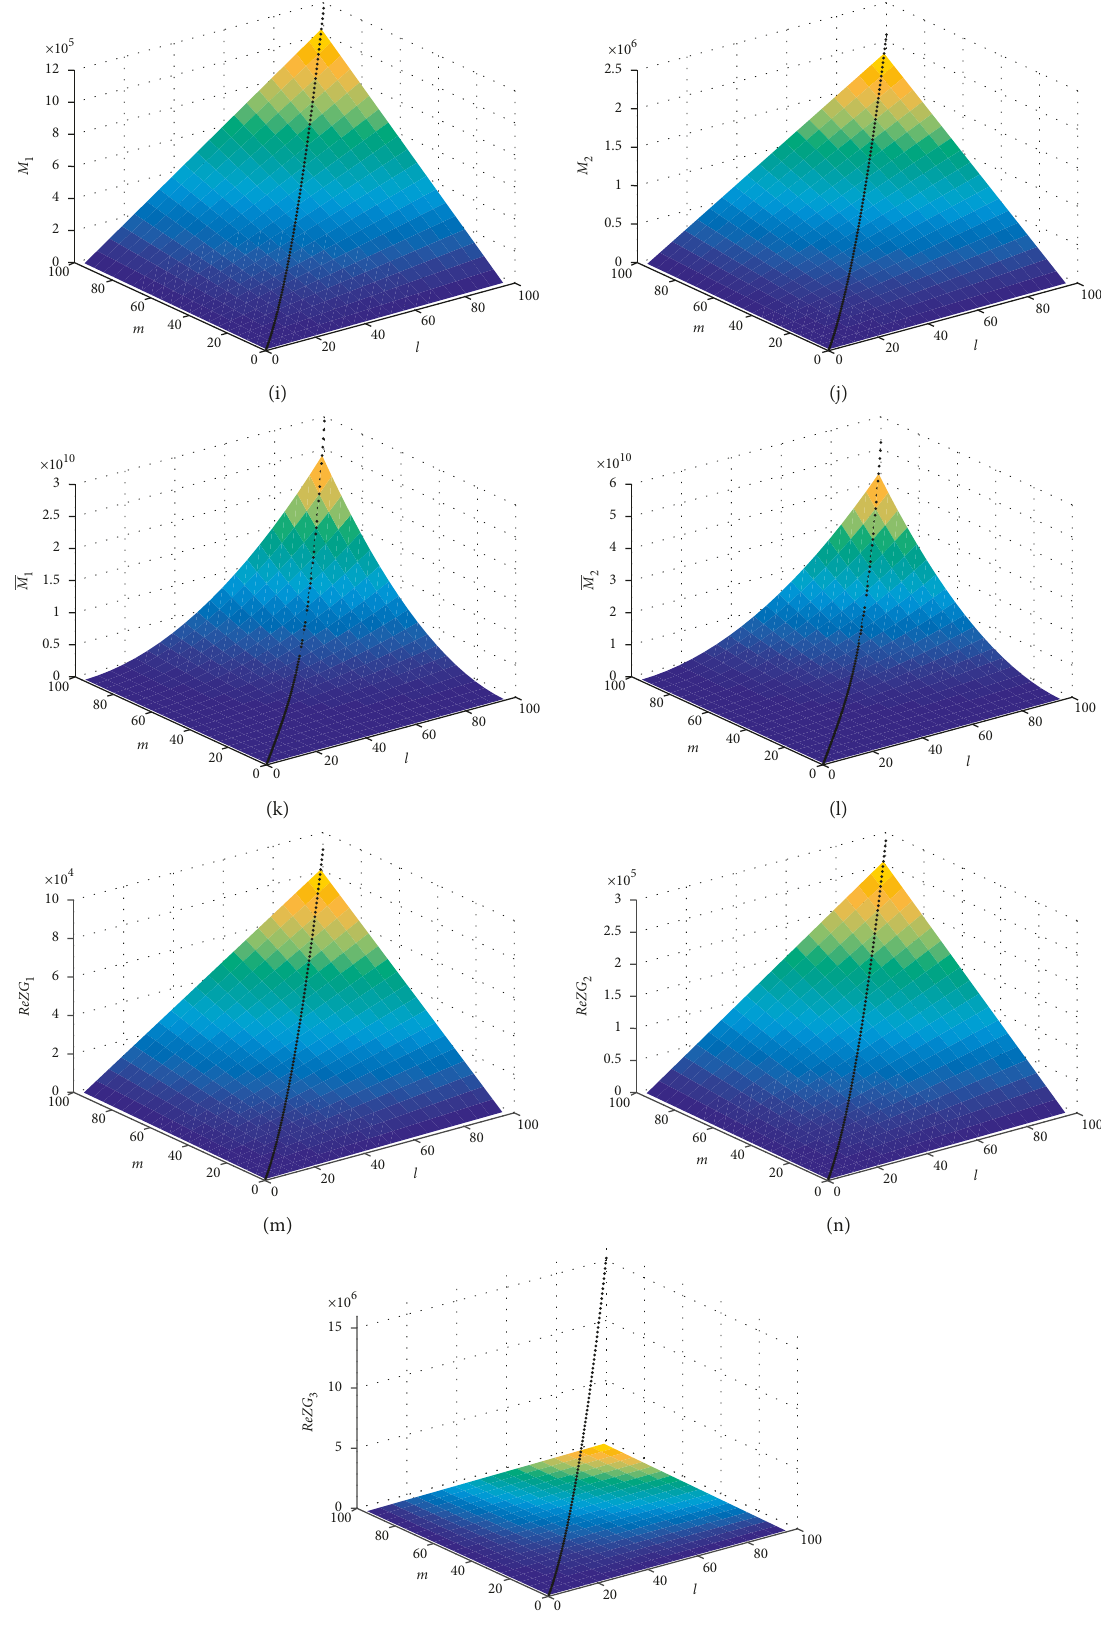
Figure 2: An interactive view of scattered plot together with surface plot of indices. (a) ( m , n , R ) . (e) ( m , n , ABC). (f) ( m , n ,GA). (g) ( m , n , F ). (h) ( m , n , AZI). (i) ( m , n , M ( m, n,R − 1/2 n , ReZG 1 ). (n) ( m , n , ReZG 2 ). (o) ( m , n , ReZG 3